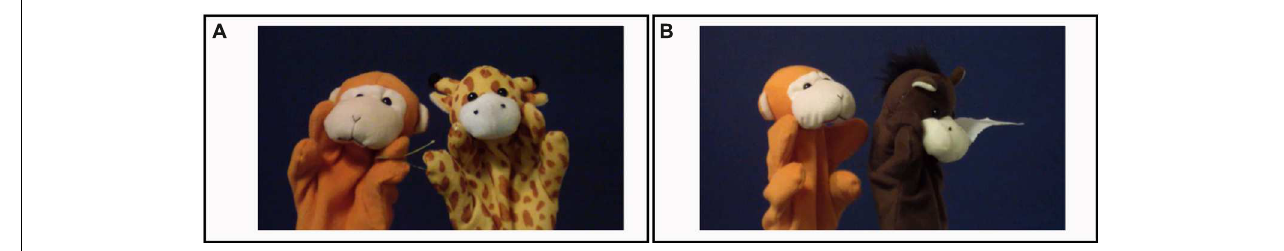
FIGURE 3 | Example stills from training videos in Experiment 2. (A) Action = monkey pinches giraffe using a clip, accompanied by a spoken AP order sentence (e.g., gund monkey giraffe clip ). (B) Action = monkey scratches donkey holding paper on the back, accompanied by a spoken PA order sentence (e.g., flern donkey monkey paper ka ).